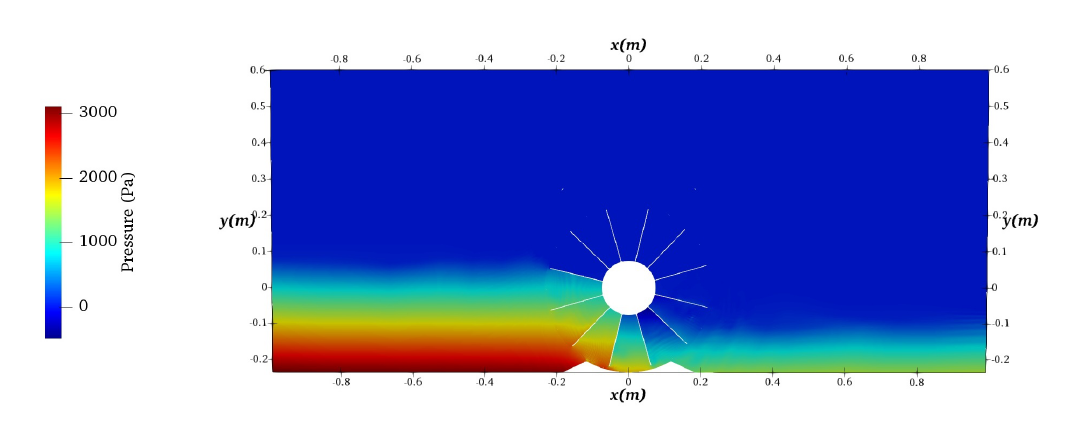
Figure 16. Slice view at the midsection of the channel of manometric Pressure, at t = 4.0 s.